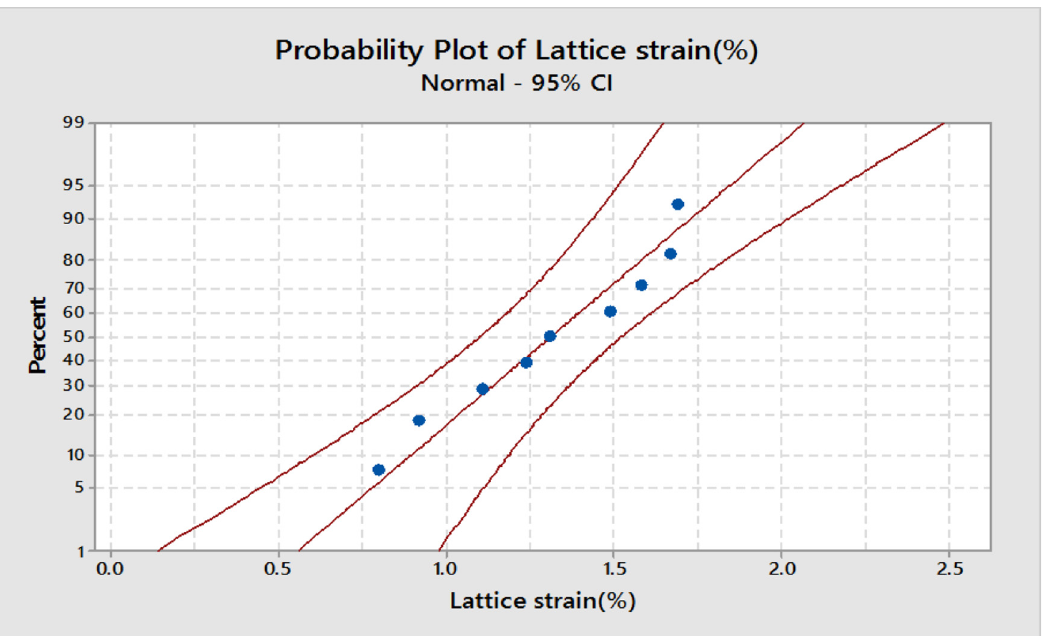
Fig. 8. Probability plot of lattice